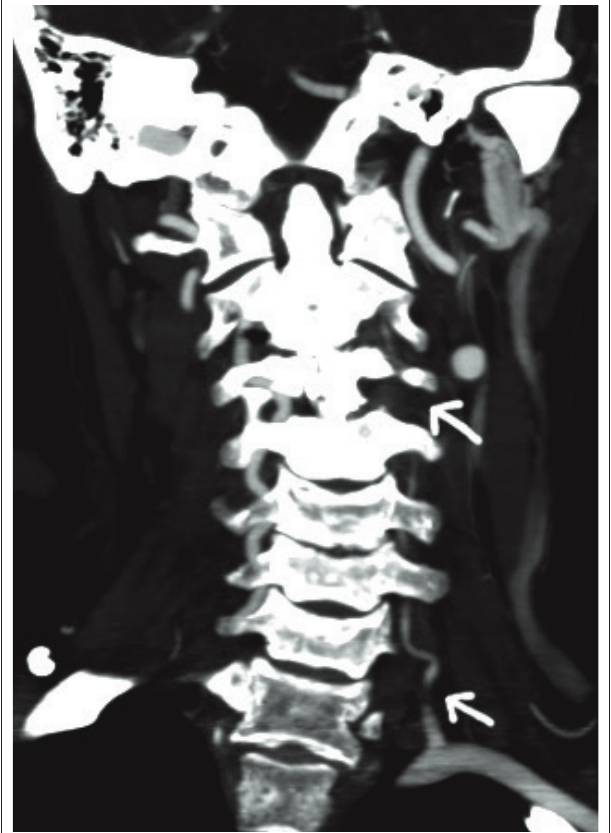
Fig. 2. Coronal MIP of a CTA of the vertebral arteries. The fracture involves the left transverse process of C3. There is diffuse spasm of the left vertebral artery with associated complete occlusion of the artery at C7 and at C3 - C4 on the left